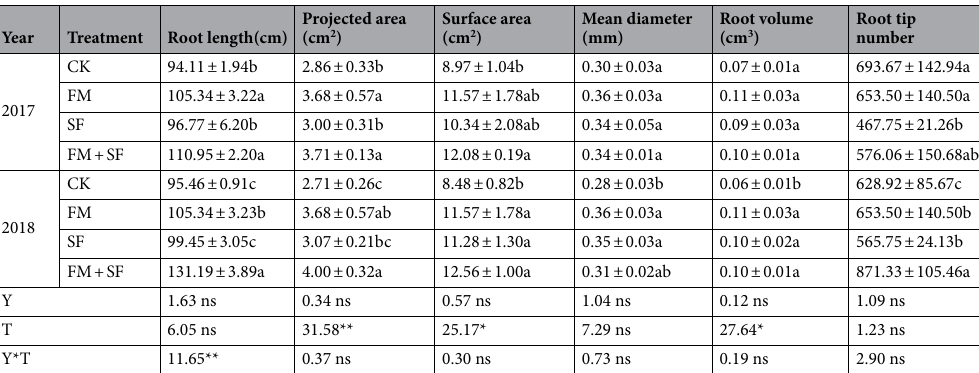
Table 2. Effects of bast fiber film and nano-silicon fertilizer treatments on root index of rice at the seedling stage. Different letters indicate significant difference at 5% level. Summary of ANOVA results: not significant (ns), significant at p < 0.05 (*), very significant at p < 0.01 (**). Y Year, T Treatment.